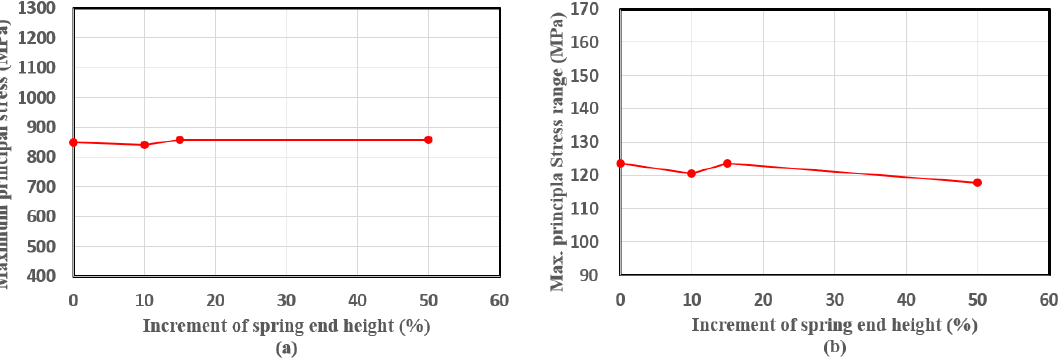
Figure 7. Stress variation with the height of spring end: ( a ) maximum principal stress; ( b ) maximum Figure 6. Fastening force vs. displacement diagram varying the spring end height difference. principal stress range.